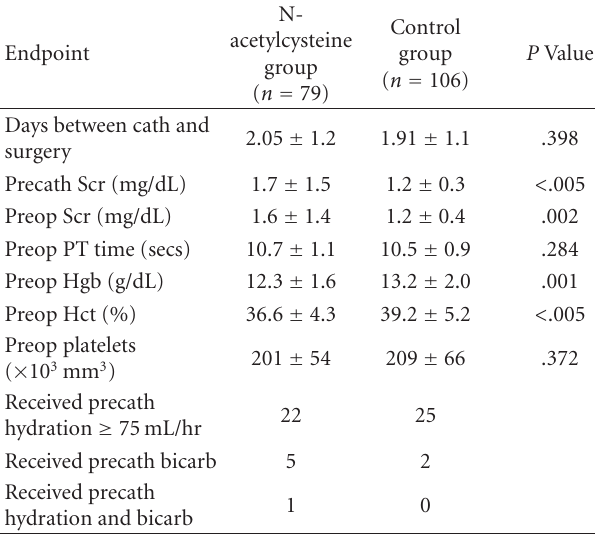
Table 2: Preoperative (Pre-op)